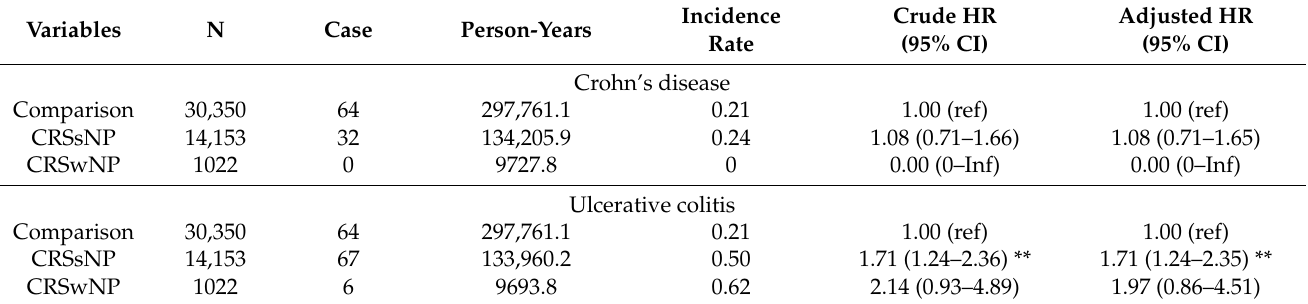
Table 4. The incidence rate (1000 person-years) and HR (95% CI) of Crohn’s disease and ulcerative colitis according to the phenotype of chronic